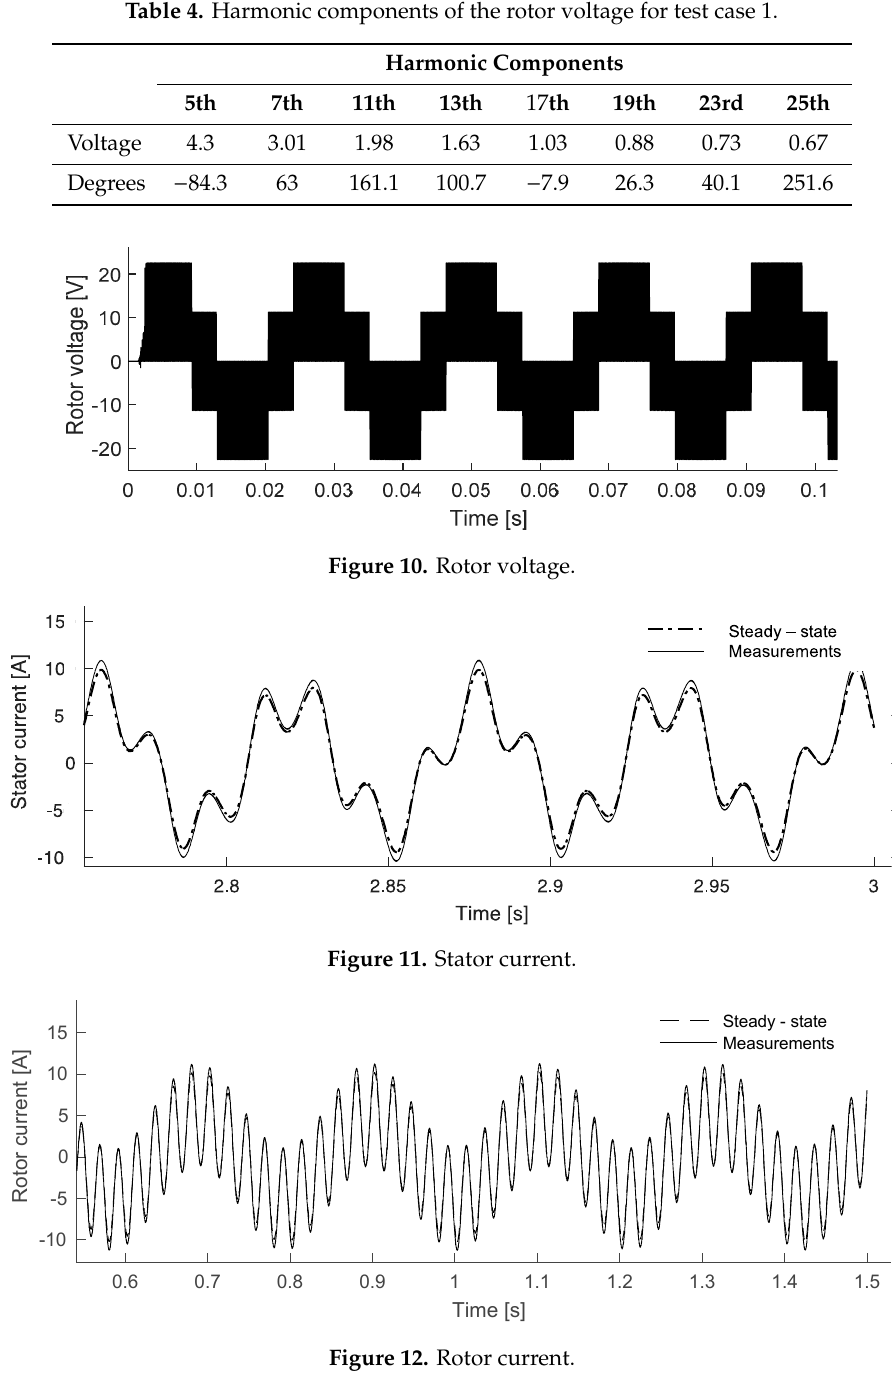
Table 5. Summary of harmonic currents for test case 1. STATOR CURRENT